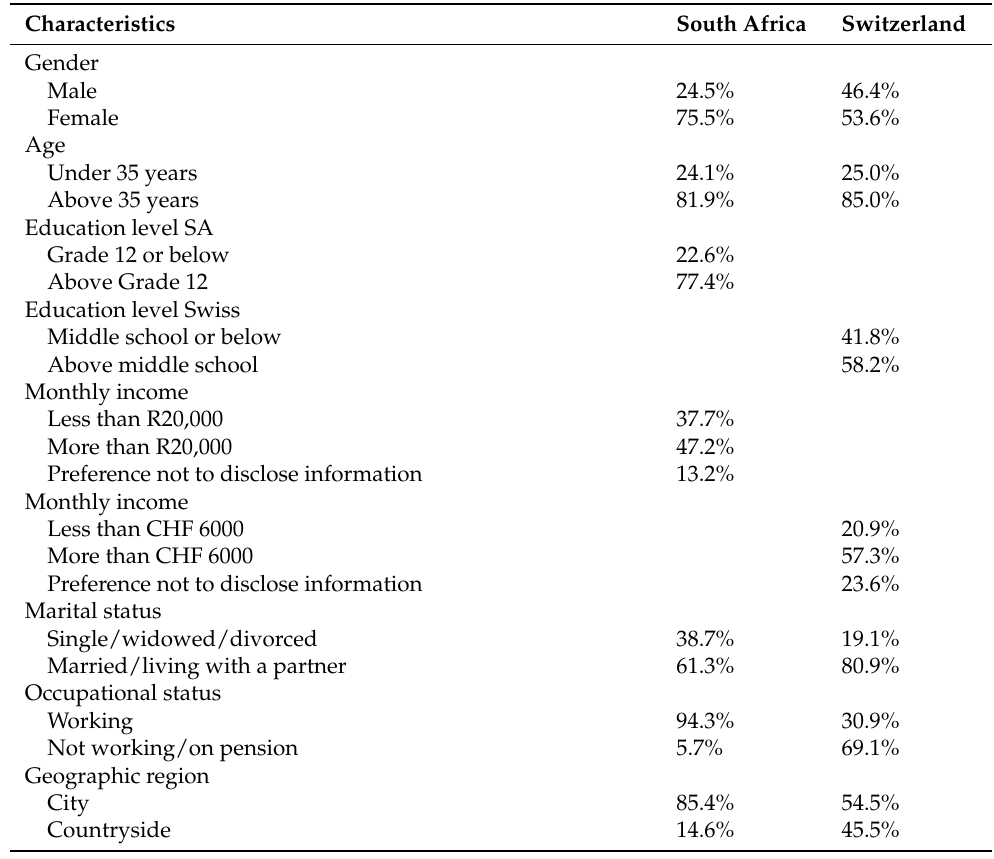
Table 1. Demographical characteristics of the study sample (n =